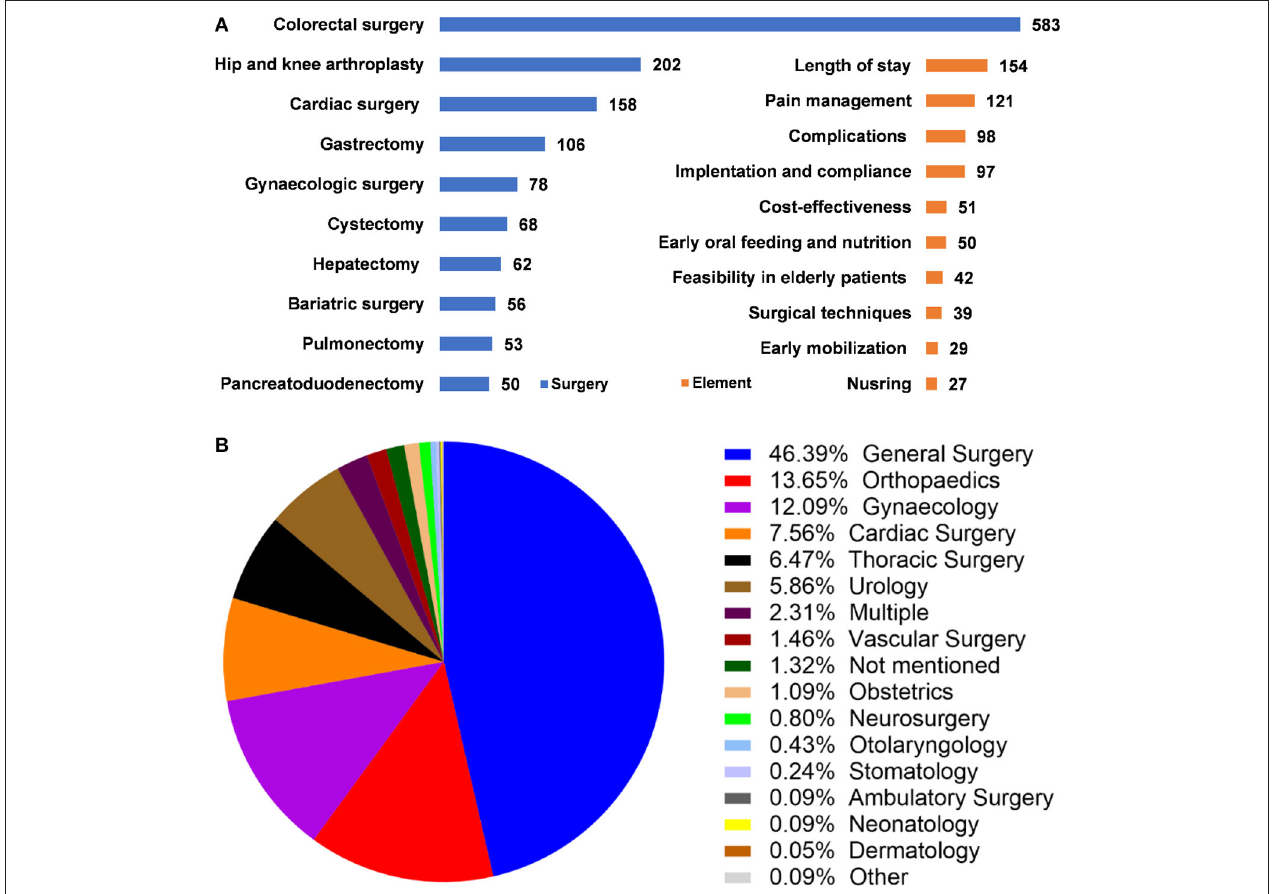
FIGURE 6 | Surgeries, most focused elements, and surgical disciplines of ERAS research. (A) Top 10 surgeries and most focused ERAS elements. (B) Surgical disciplines that implement ERAS